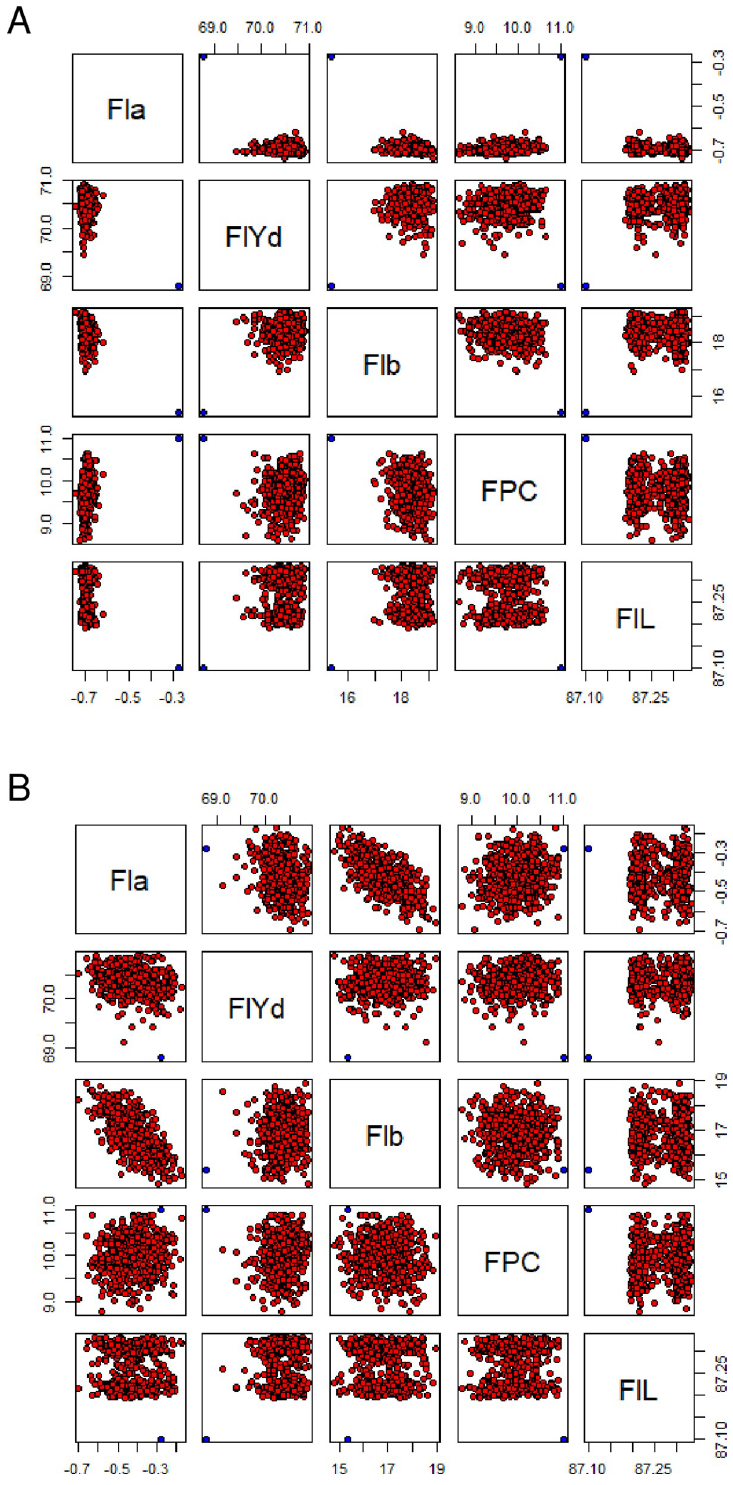
Fig 4. Scatter diagrams of predicted values for the five traits. Predicted values of derivatives from Ideotype 1 (A) and Ideotype 8 (B). Points in blue indicate Kitahonami’s values.